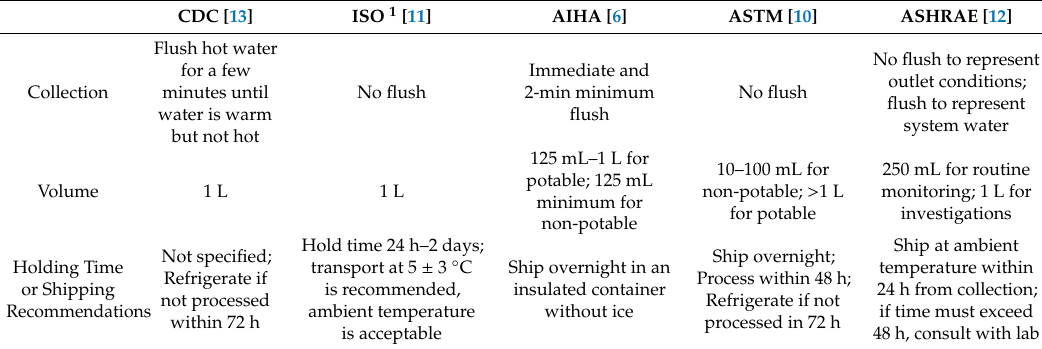
Table 1. Summary of sample collection, holding time, and shipping